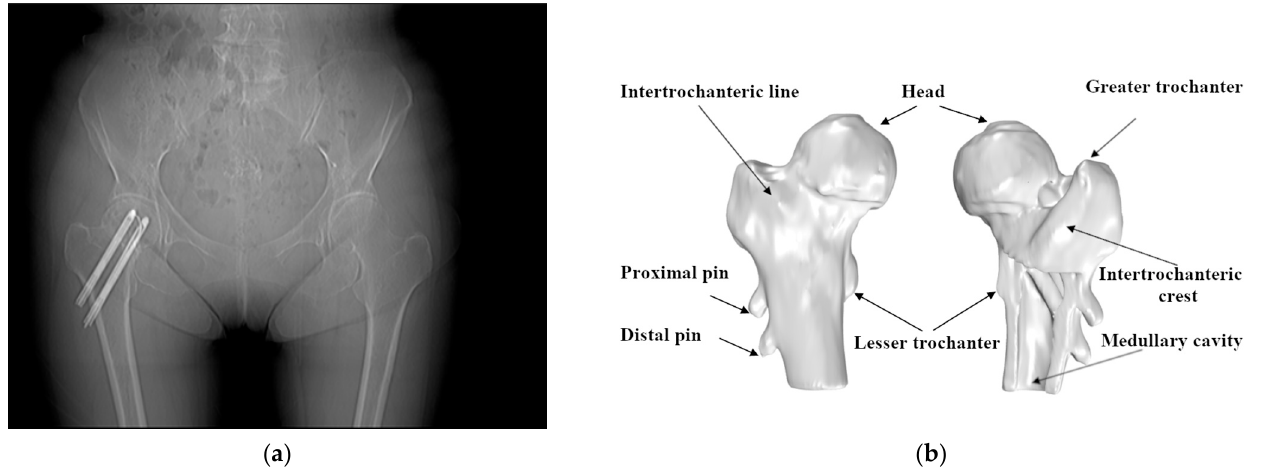
Figure 2. Use of the Hansson pin for the fixation of femoral neck fractures: ( a ) the anteroposterior/posteroanterior X-ray (AP X-ray) of intracapsular fracture fixation using two Hansson pins; ( b ) the position of the Hansson pins in the anatomy of the femur.